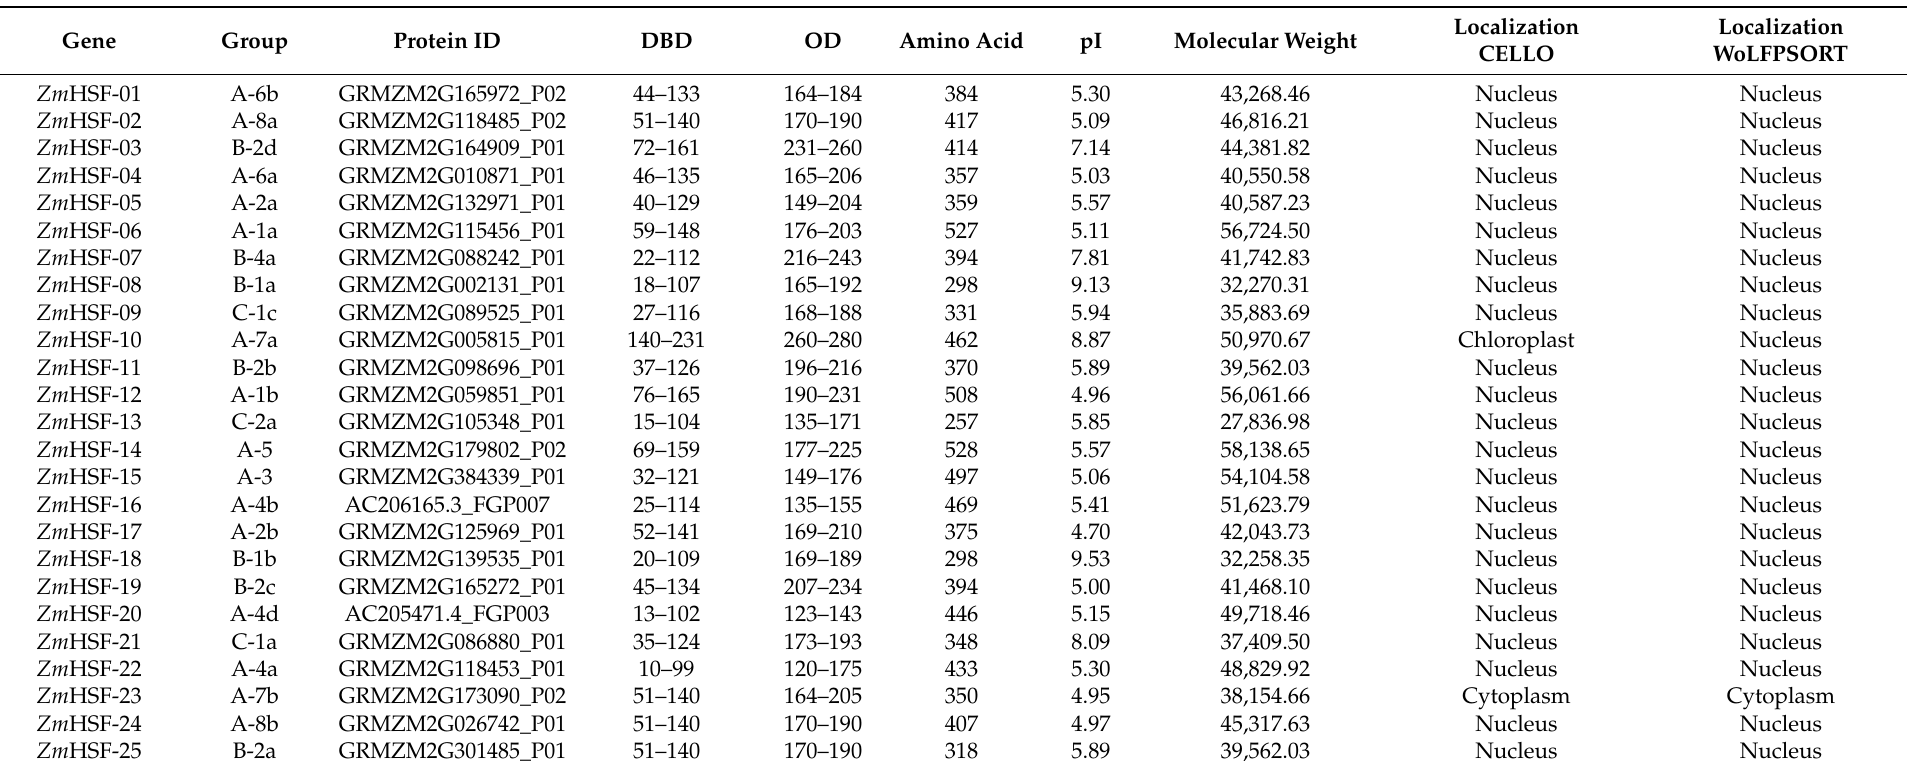
Table 5. The physio-chemical properties of maize HSFs proteins including group, protein ID, domains, amino acid physio-chemical properties, and sub-cellular